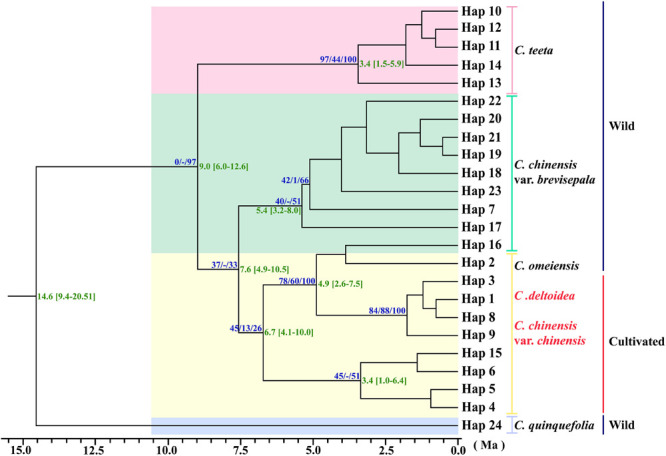
Phylogenetic relationships analysis using Maximum Parsimony (MP) methods based on cpDNA data. The numbers above the branches are bootstrap support values of Neighbor-Joining and Maximum parsimony tree, and Bayesian posterior probabilities (PPs) of 100% of BI tree (NJ/MP/BI) between major lineages. Time scale (with 95% HPD intervals in square brackets) are shown to the right of each node with green color. The red letter indicates that the sample is from cultivated.